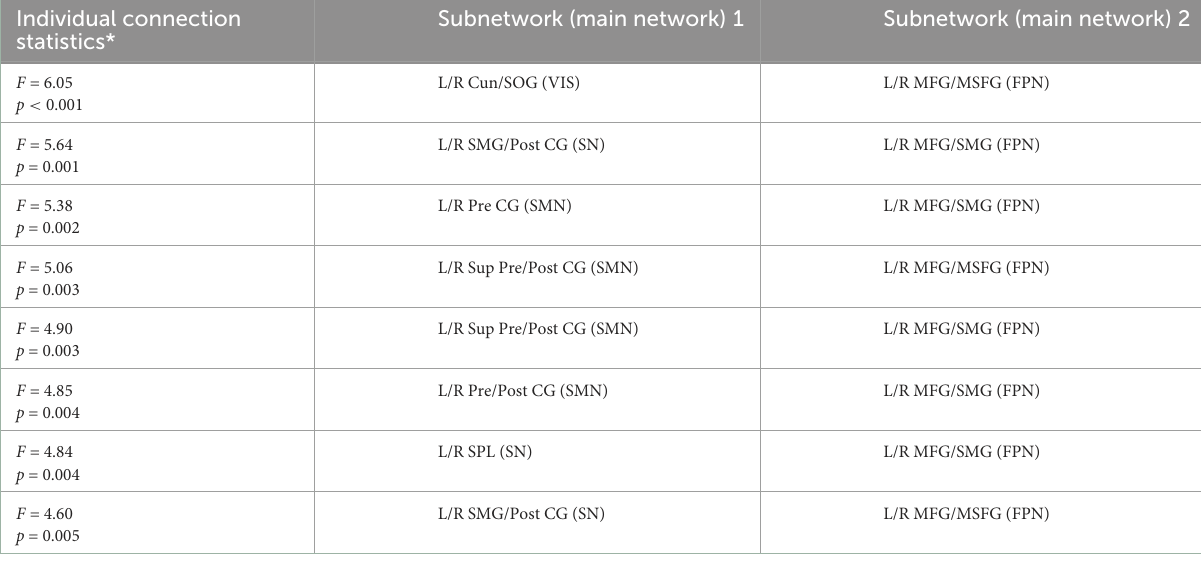
TABLE 2 Significant connections for interaction over 36 months between intervention group and baseline CDR status. Individual connection